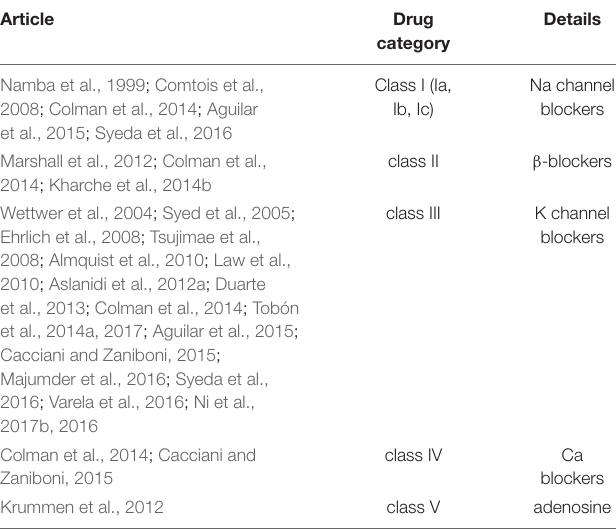
TABLE 2 | Studies focusing on each anti-arrhythmic drug